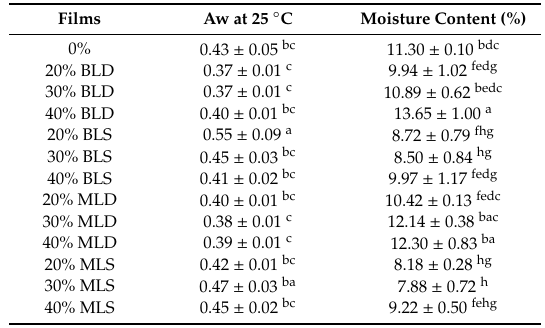
Table 4. Water activity and moisture content of films with 0%, 20%, 30% and 40% of freeze-dried blackberry pulp (BL) and freeze-dried microencapsulated blackberry pulp (ML) incorporated directly (D) and by sprinkling (S). Results of the control film characterization (0%) were published by Nogueira, Fakhouri and Oliveira